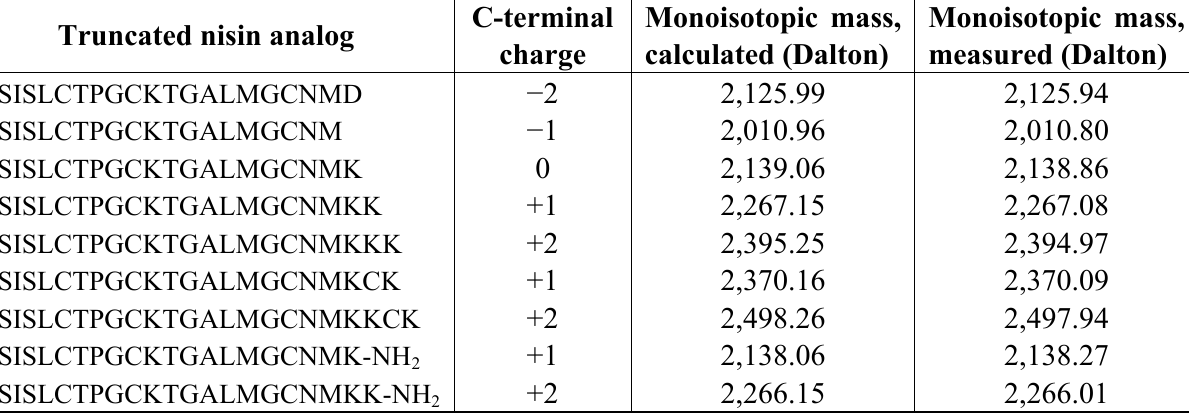
Table 4. Truncated nisin analogs with different C-terminal